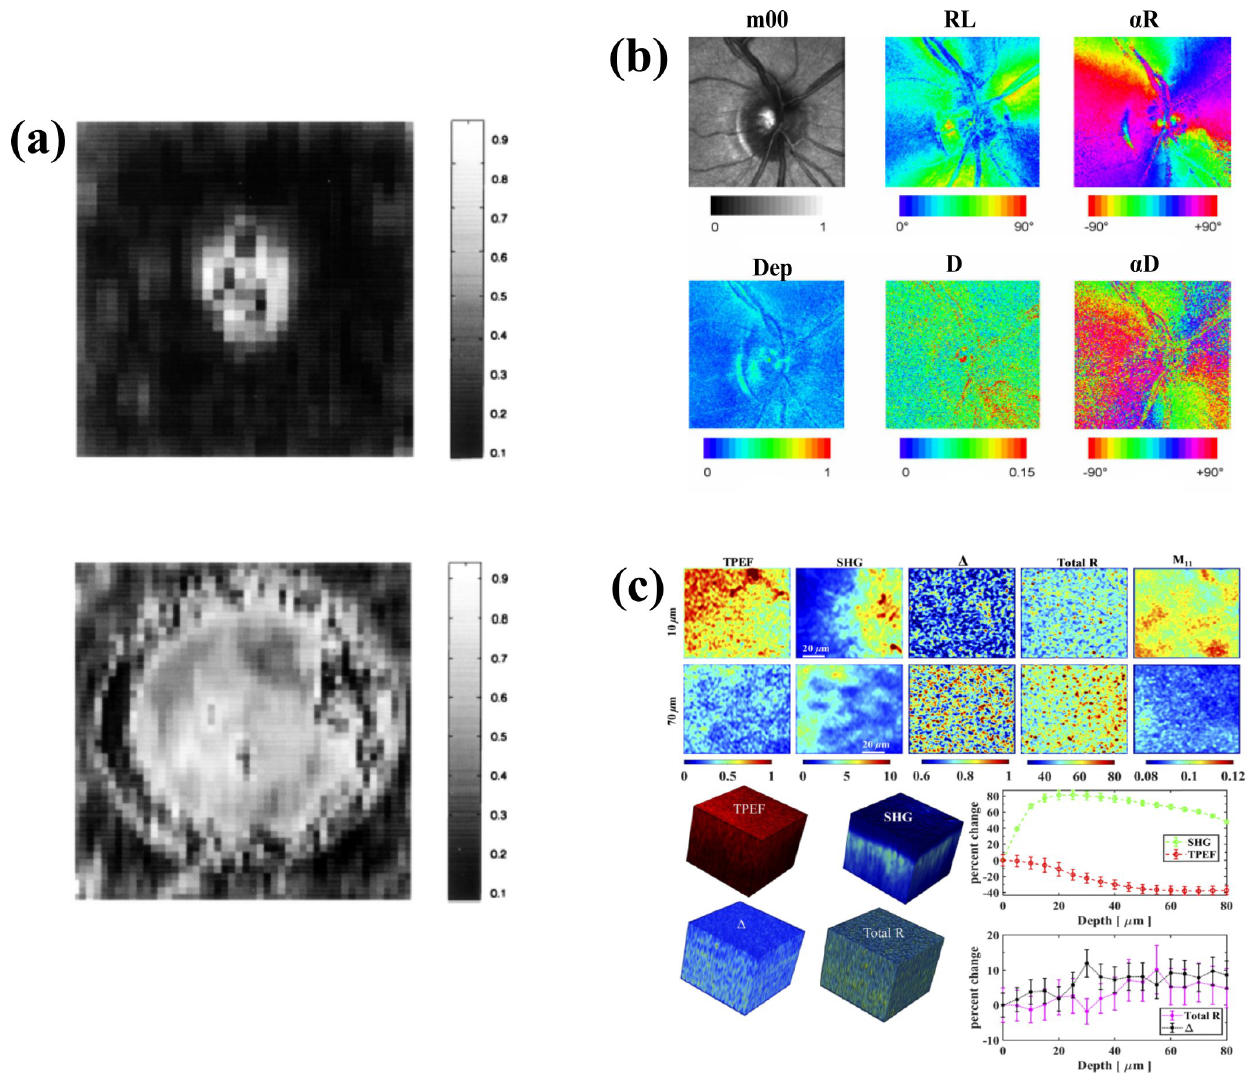
Figure 5. Quantitative imaging of the full Mueller matrix for ophtalmology applications. ( a ) Degree of polarization images of the retina for two different size of pupil. ( b ) Polarization parameter images of the optical nerve head. These images corresponds to the normalized average intensity m00; linear retardance—RL; retardance orientation α R ; depolarization index Dep; diattenuation D; diattenuation orientation α D . and ( c ) Quantitative analysis of a rat cornea polarization resolved image. Top two rows correspond to images at 10 and 70 µ m depth while bottom row shows 3D volume of Second Harmonic Generation (SHG) and Two-Photon Excitation Fluorescence (TPEF), and percent change. Adapted with permission from: ( a ) [44]; ( b ) [49]; ( c ) [52], © The Optical